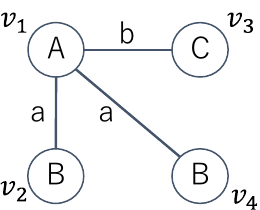
Figure 3. Example of a